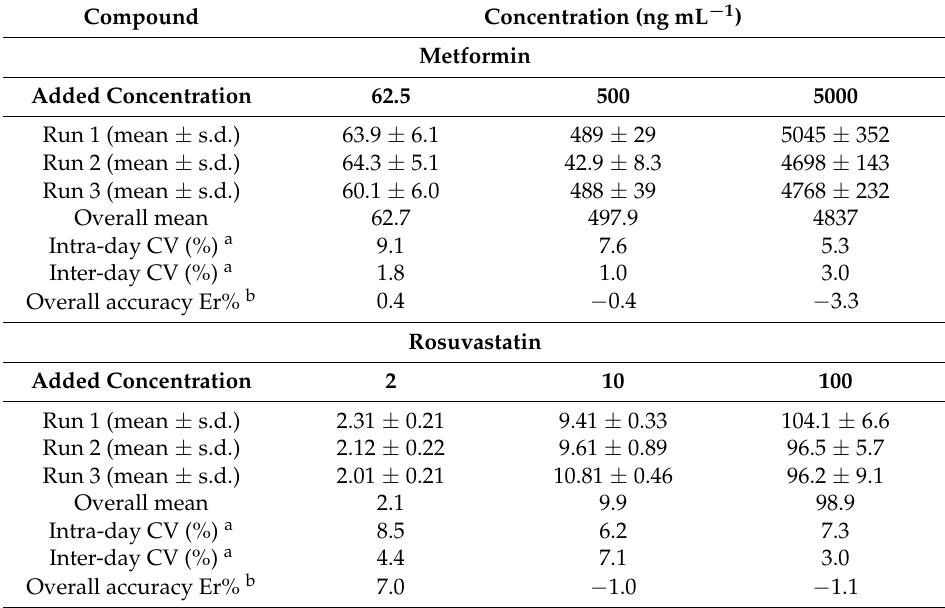
Table 2. Data on accuracy and precision obtained from the analysis of quality control samples containing rosuvastatin and metformin (n = 3 runs; five replicates per run).